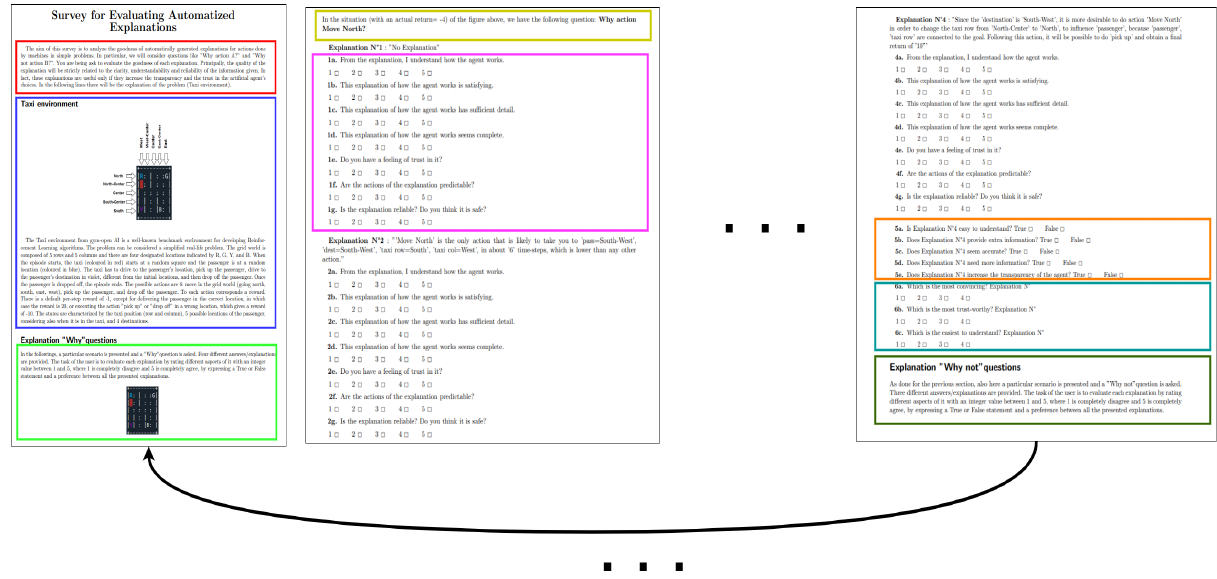
Figure A1. Structure of the